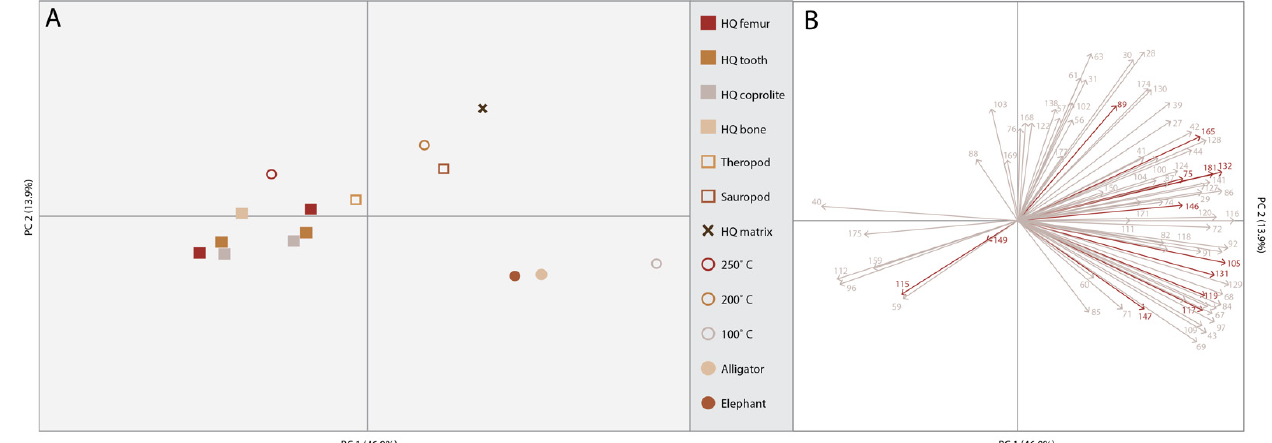
Figure 1. Principal component analysis. ( A ) PCA of chemical signature of 86 organic and inorganic peaks. HQ femur, HQ tooth and HQ coprolite are all thin sections from H2, and HQ bone is an untreated bone fragment from H4. The HQ matrix is from H4. The modern bones (alligator and elephant) and the 100 °C are more similar chemically to one another than the other samples. The HQ fossils show little variation between one another, but there is a greater amount of variation with the associated matrix. Therefore, there are amino acids present in the fossils that are not present in the associated matrix. ( B ) PCA Loadings show how each one of the 86 peaks influences the specimen placement in the PCA.